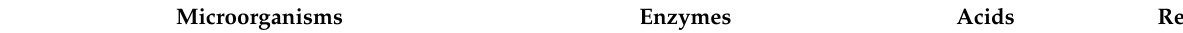
Table 4. Plant growth promoting and bio controlling enzymes and acids producing phosphate solubilizing